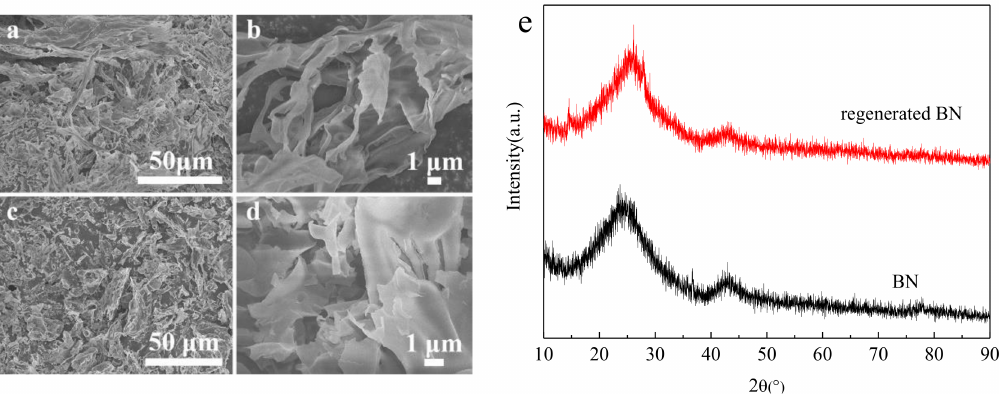
Figure 9. SEM images of the flake BN ( a , b ) and the regenerated flake BN after cycles ( c , d ); ( e ) XRD of the flake BN before and after